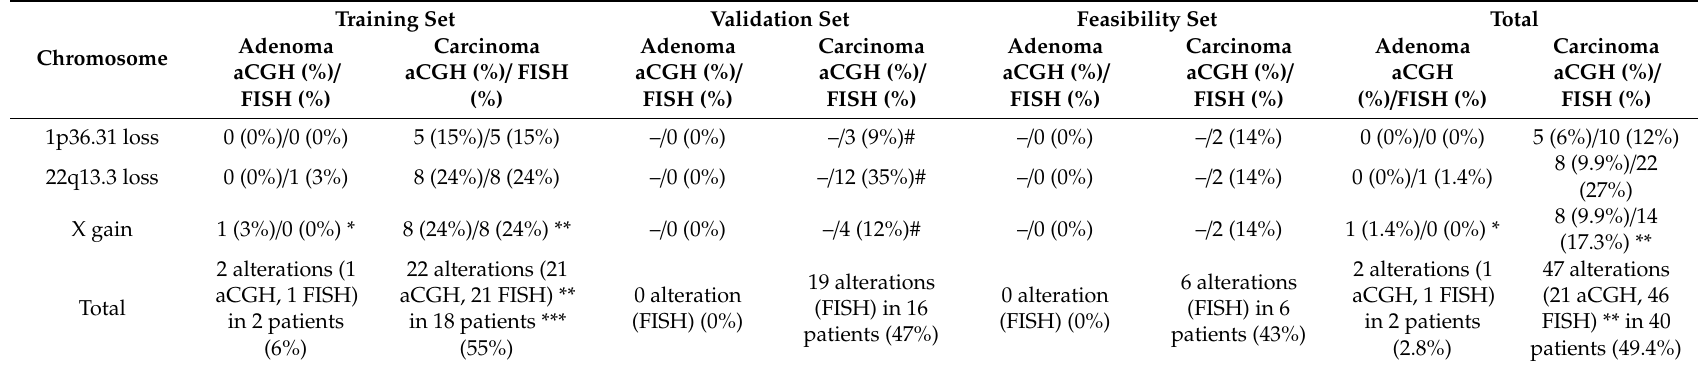
Table 2. Detection of the three genetic anomalies in classic follicular adenoma (cFA) and carcinoma (cFTC) in the training, validation and feasibility sets: comparison between aCGH and Triple DNA FISH